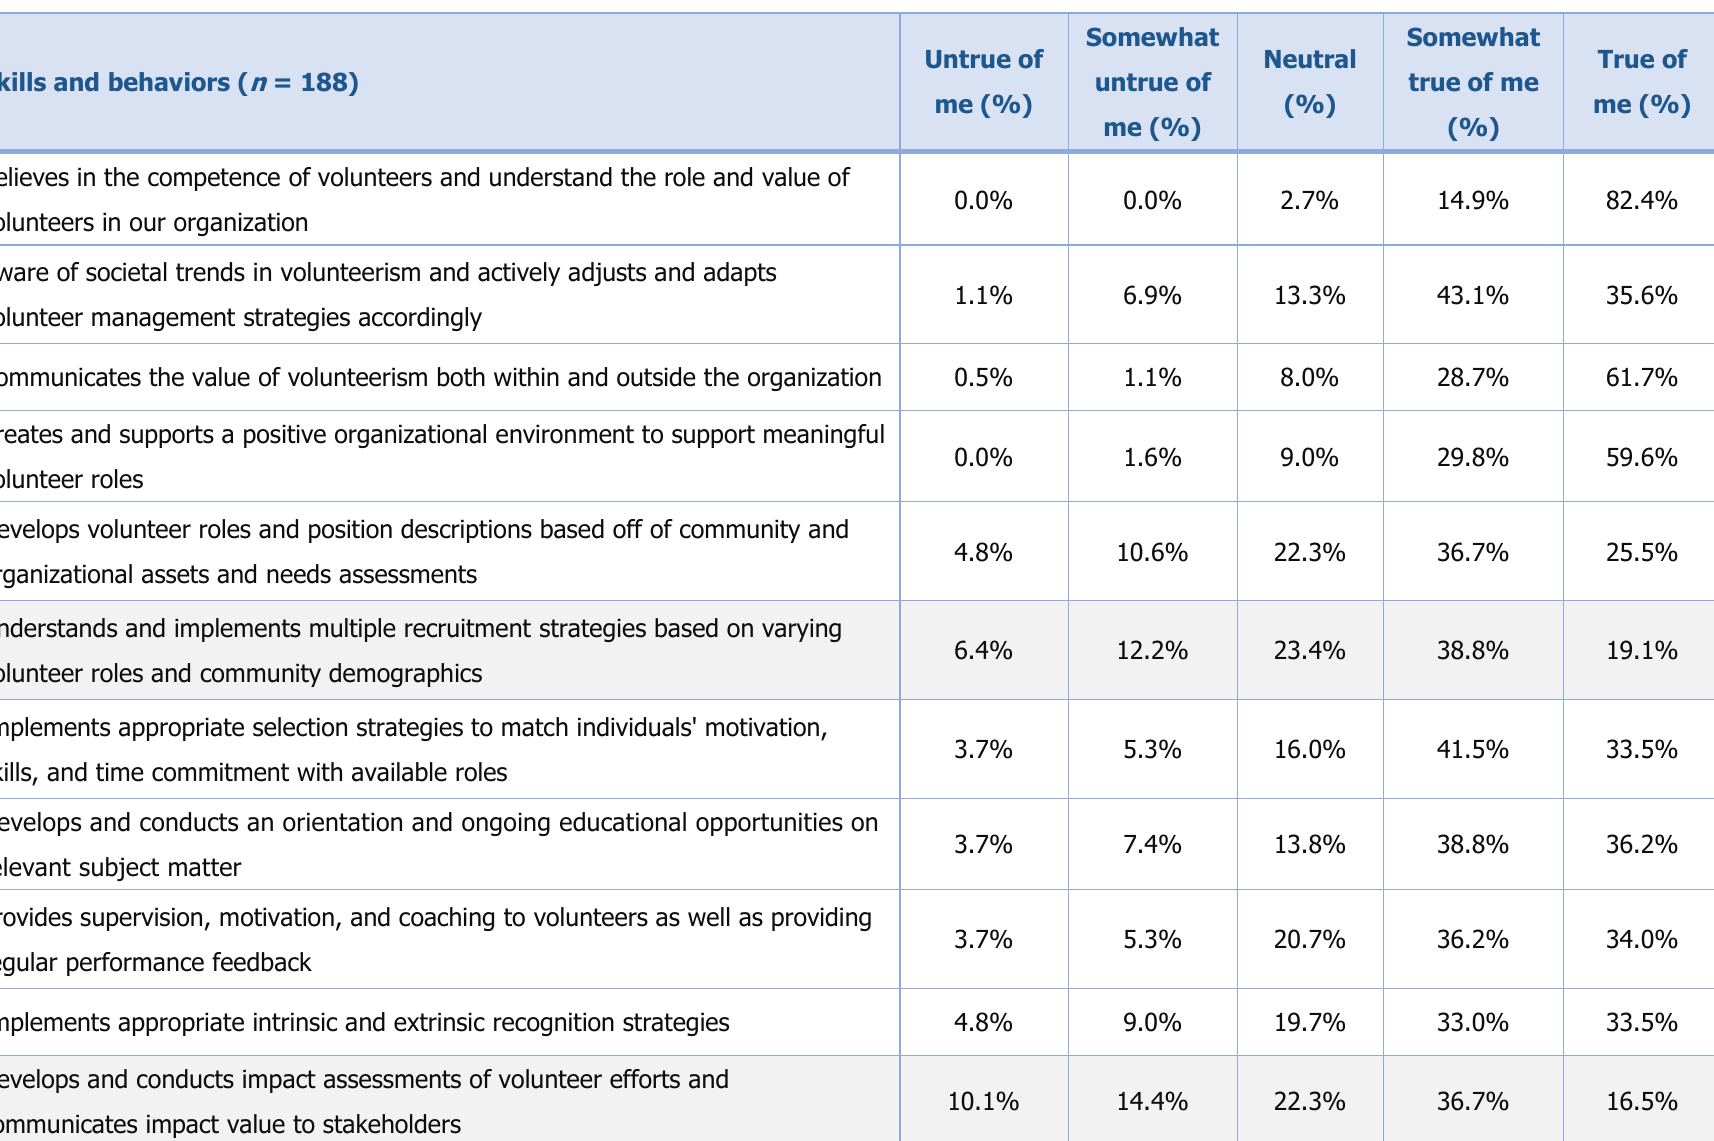
Table 5. Volunteerism Competencies (Building and Maintaining a Volunteer Program Management System for the Delivery of Youth Development